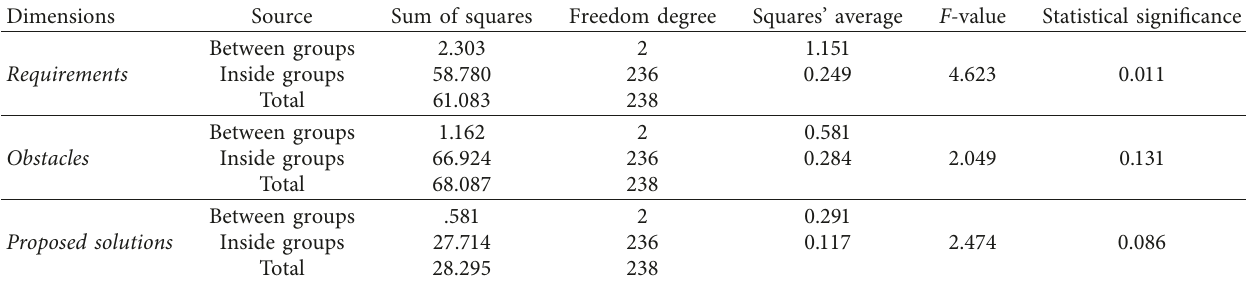
Table 11: Analyzing the impact of scientific rank on requirements, challenges, and solutions for online education in the face of university educational crises.